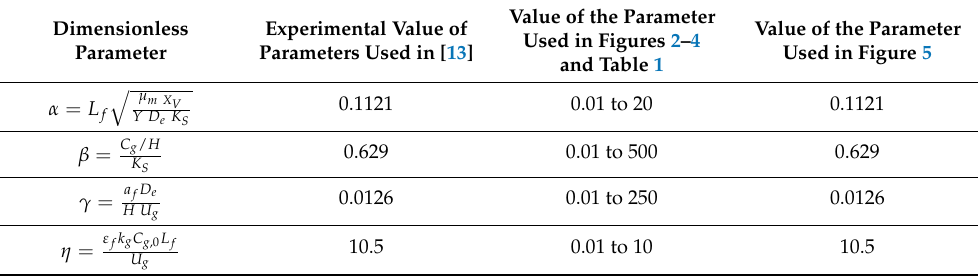
Table A2. Experimental Dimensionless Values of the Parameters [13] Used in This Work (Figures 2–4 and Table 1). Value of the Parameter Dimensionless Experimental Value of Used in Figures 2–4 Parameter Parameters Used in [13] and Table